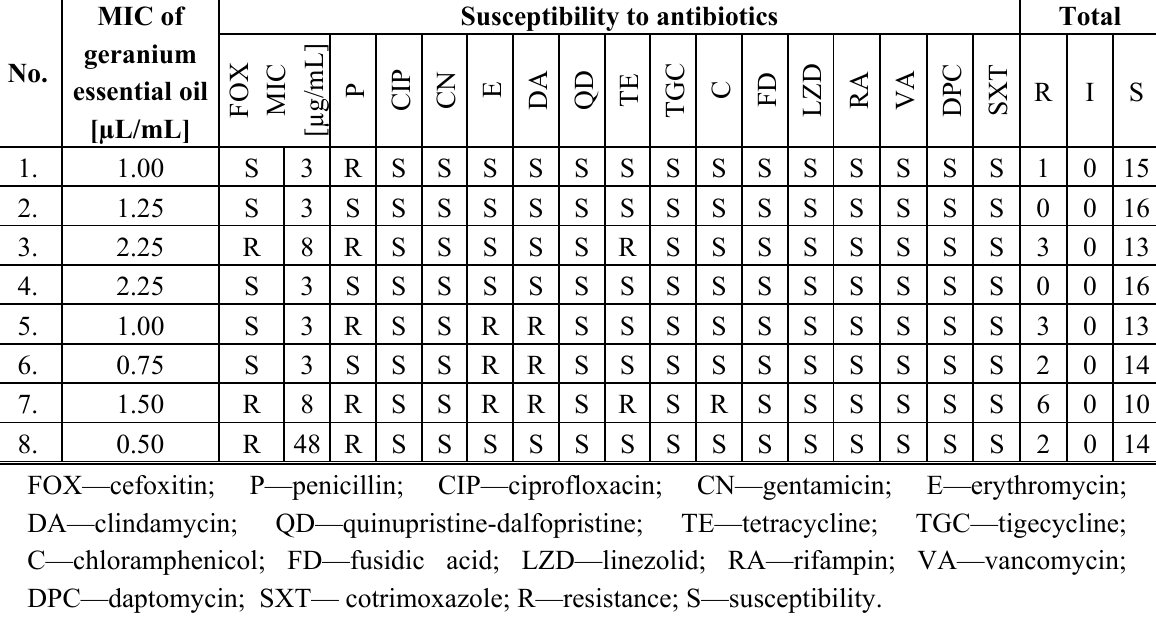
Table 4. Characteristics of S. aureus strains isolated from postoperative